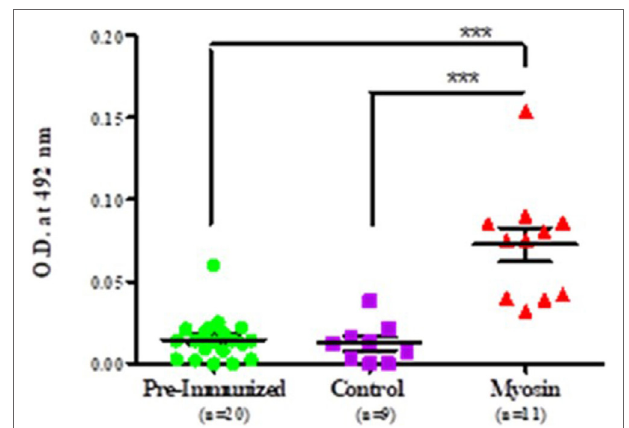
FigUre 2 | Level of lymphoproliferation in the presence of myosin in leprosy patient across the spectrum. Graphical representation is done by Box and Whiskers. Each bar represents the minimum to maximum values with median as the horizontal line and SD as error bars. + sign in each bar represent the mean value. Dotted line represents the S.I. = 2 (** p < 0.001, * p < 0.05).